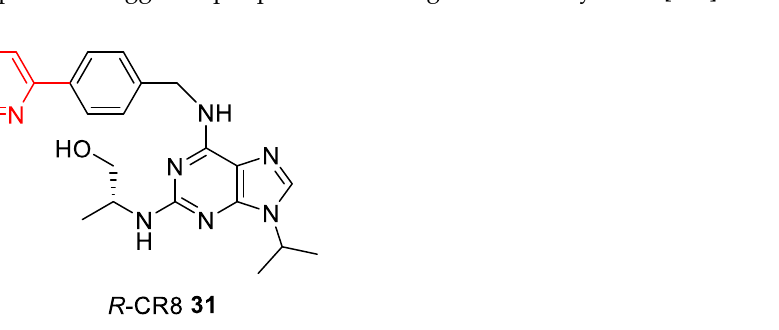
Figure 8. Chemical structure of CR8. A surface-exposed 2-pyridyl moiety of CR8 is responsible for glue degrader properties.